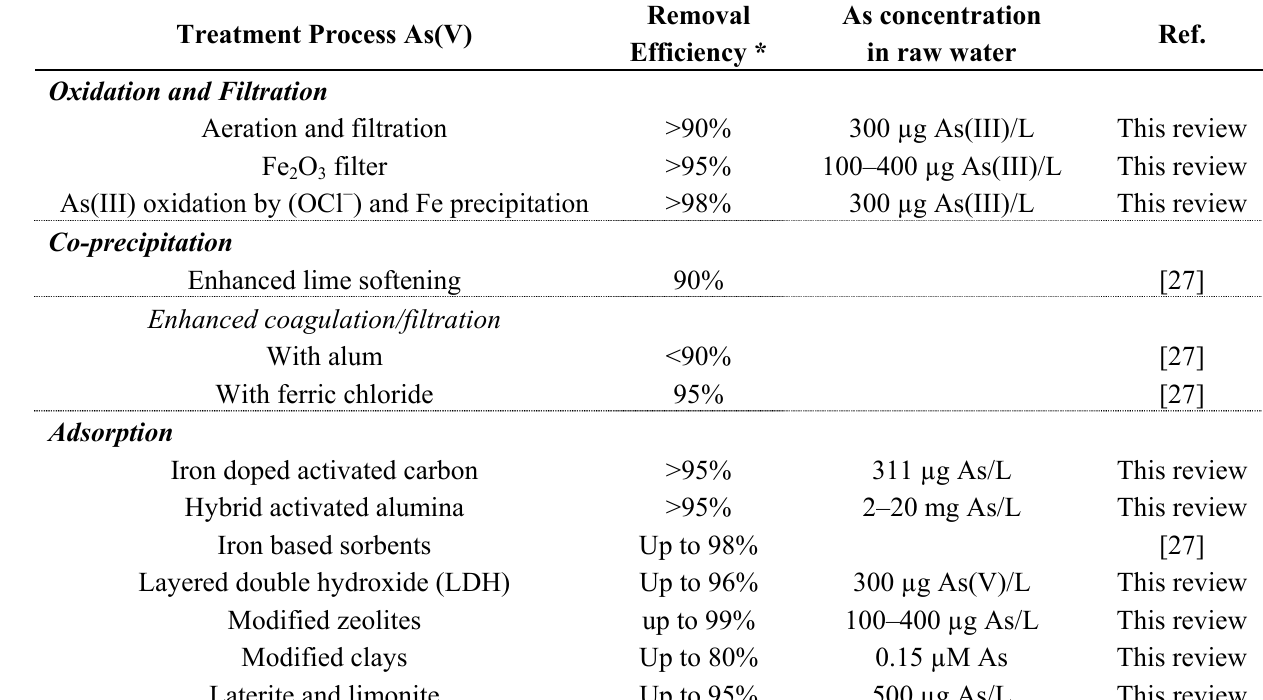
Table 4. Technologies and treatment